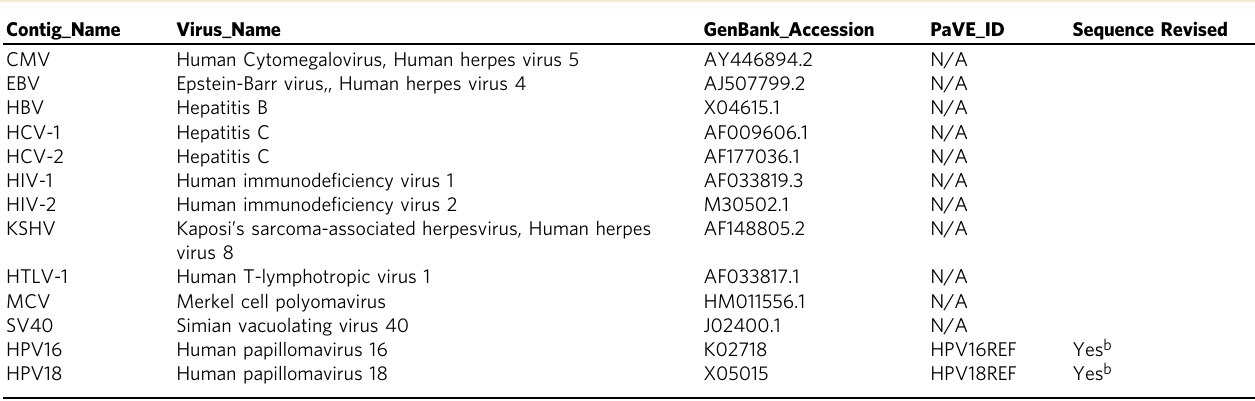
Table 1 Virus Sequences included in the GDC reference genome a